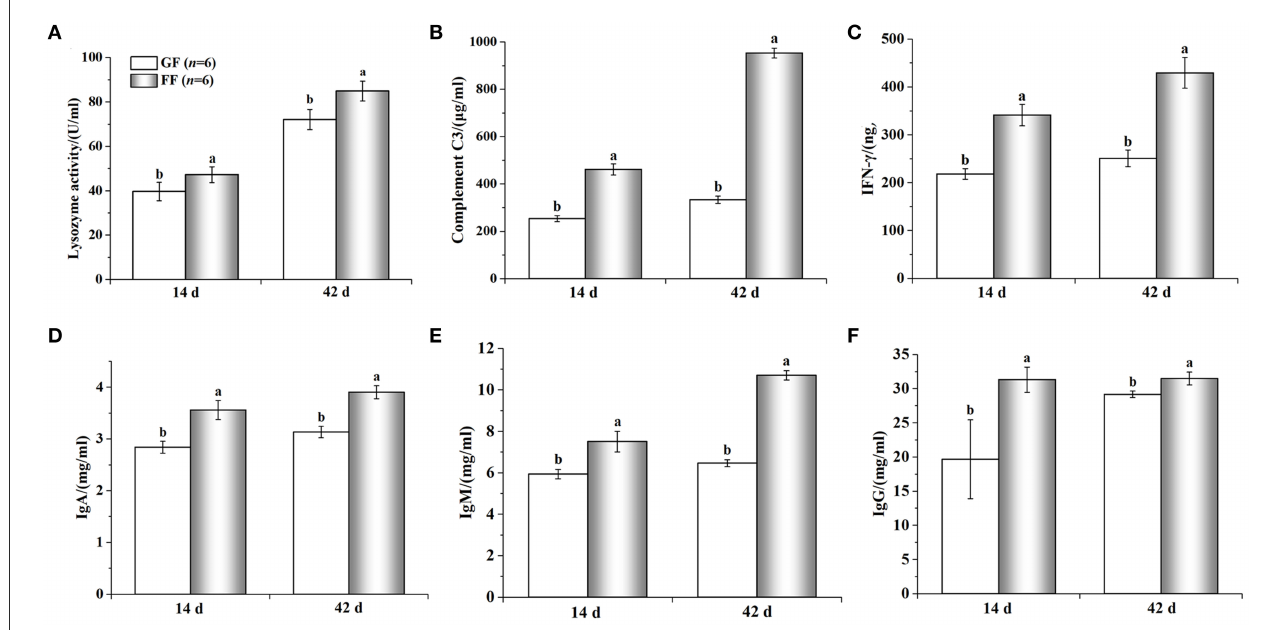
FIGURE5 Effects of dietary FF or GF on immunologic factors [ (A) : Lysozyme activity; (B) : Complement C3; (C) : IFN- γ ; (D) : IgA; (E) : IgM; (F) : IgG] in the serum of piglets.